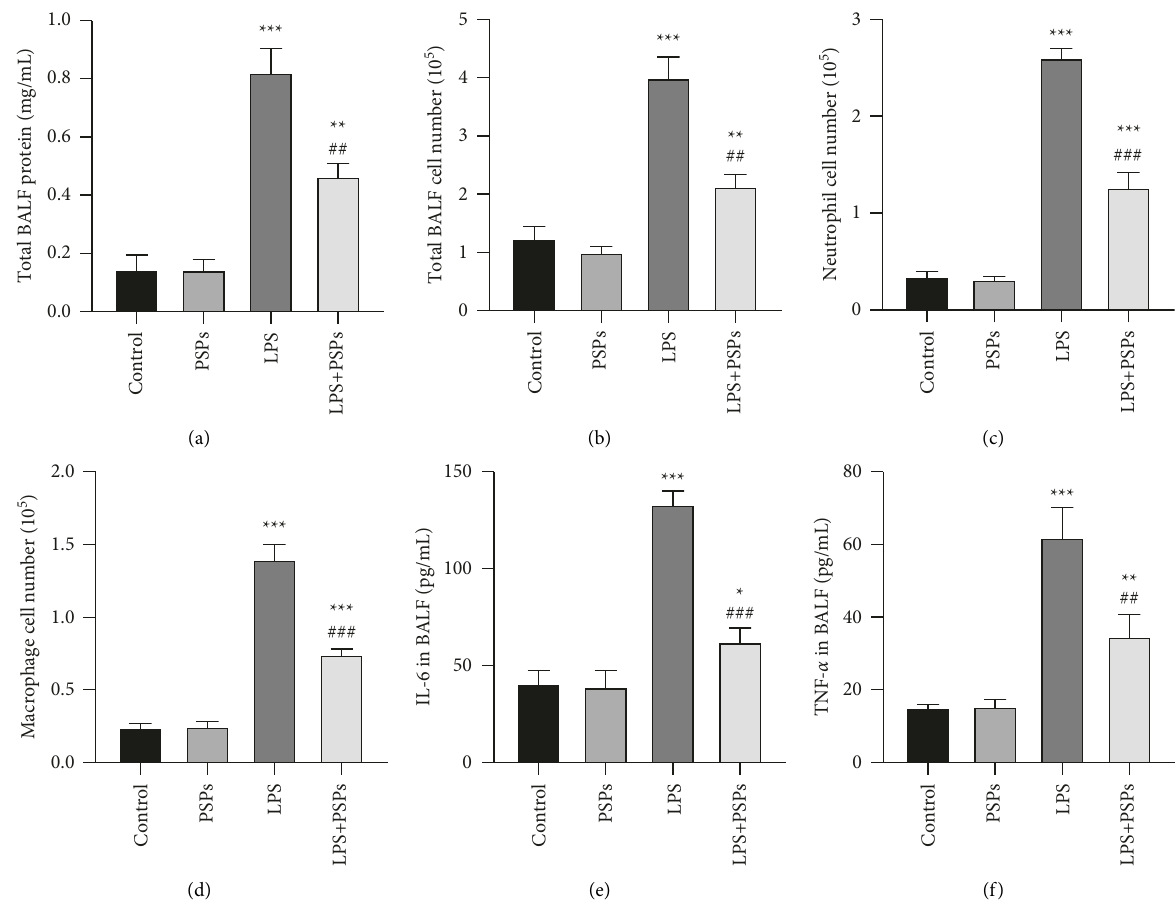
Figure 10: BALF analysis of the effect of PSPs on the inflammatory response in ALI mice. (a) The total protein concentration in BALF of each group. (b) The total number of inflammatory cells in BALF in each group. (c) The number of neutrophils in BALF in each group. (d) The number of macrophages in BALF in each group. (e) IL-6 levels in BALF of each group. (f) TNF- α levels in BALF of each group. Compared with the control